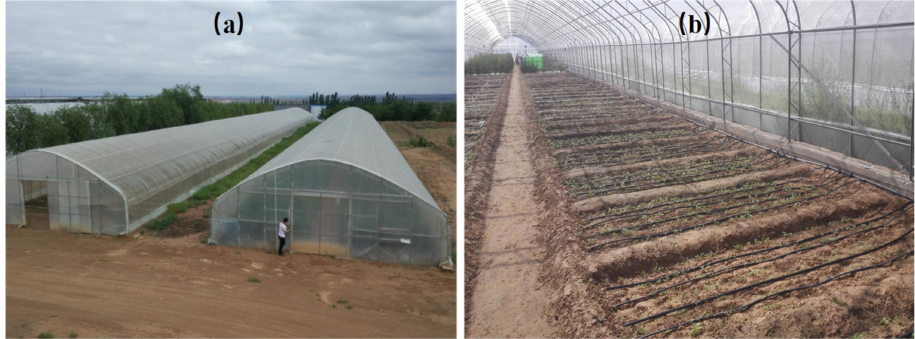
Figure 1. Photograph of the screenhouse ( a ) external view, ( b ) internal